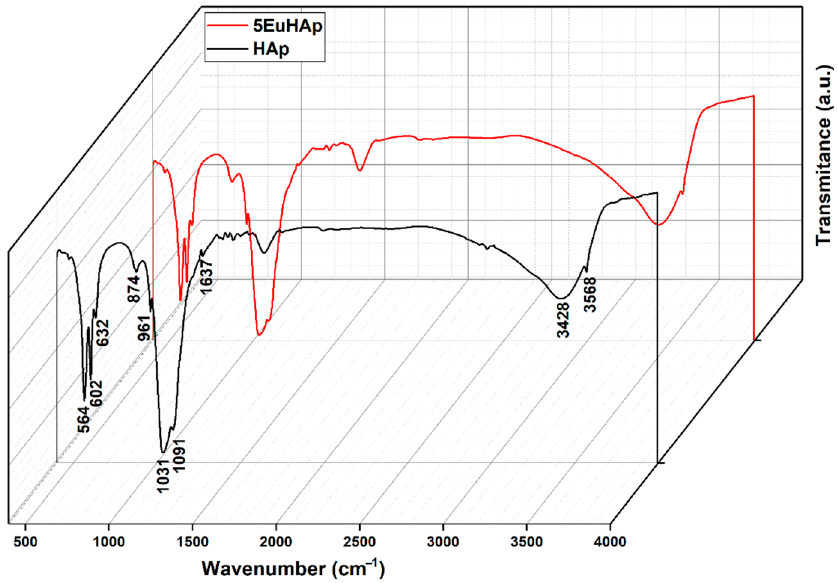
Figure 7. 3D representation of FTIR spectra obtained on hydroxyapatite and europium-doped hydroxyapatite thin films (x Eu = 0.05) deposited on Si substrate.